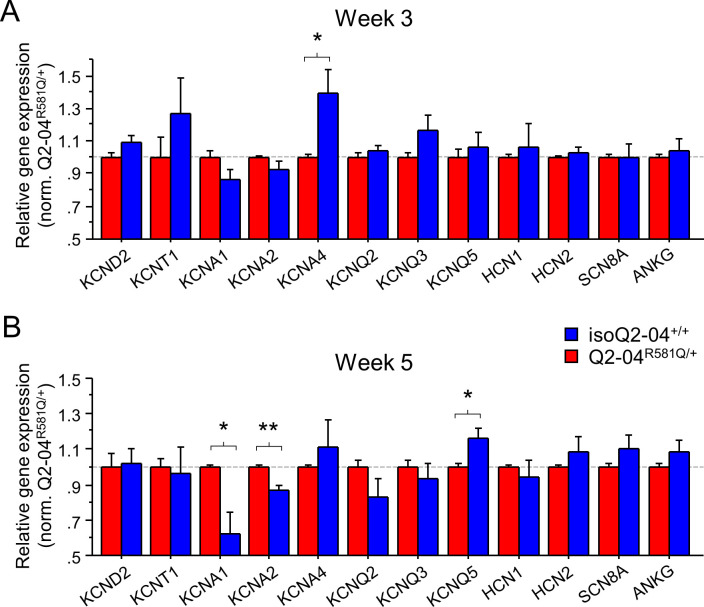
Expression of ion channel genes in KCNQ2-DEE neurons.(A) qPCR gene expression pattern of ion channels at week 3. KCNA4 expression was significantly higher in Q2-04R581Q/+ neurons (t test: *p=0.0216). (B) At week 5, expression of KCNA1 and KCNA2 was significantly higher in Q2-04R581Q/+ neurons (t test: *p=0.0099, **p=0.0017, respectively). Expression of KCNQ5 was significantly lower in Q2-04R581Q/+ neurons (t test: *p=0.0198). Values displayed are mean ± SEM from three independent differentiations normalized within each differentiation to Q2-04R581Q/+ of each time-point.